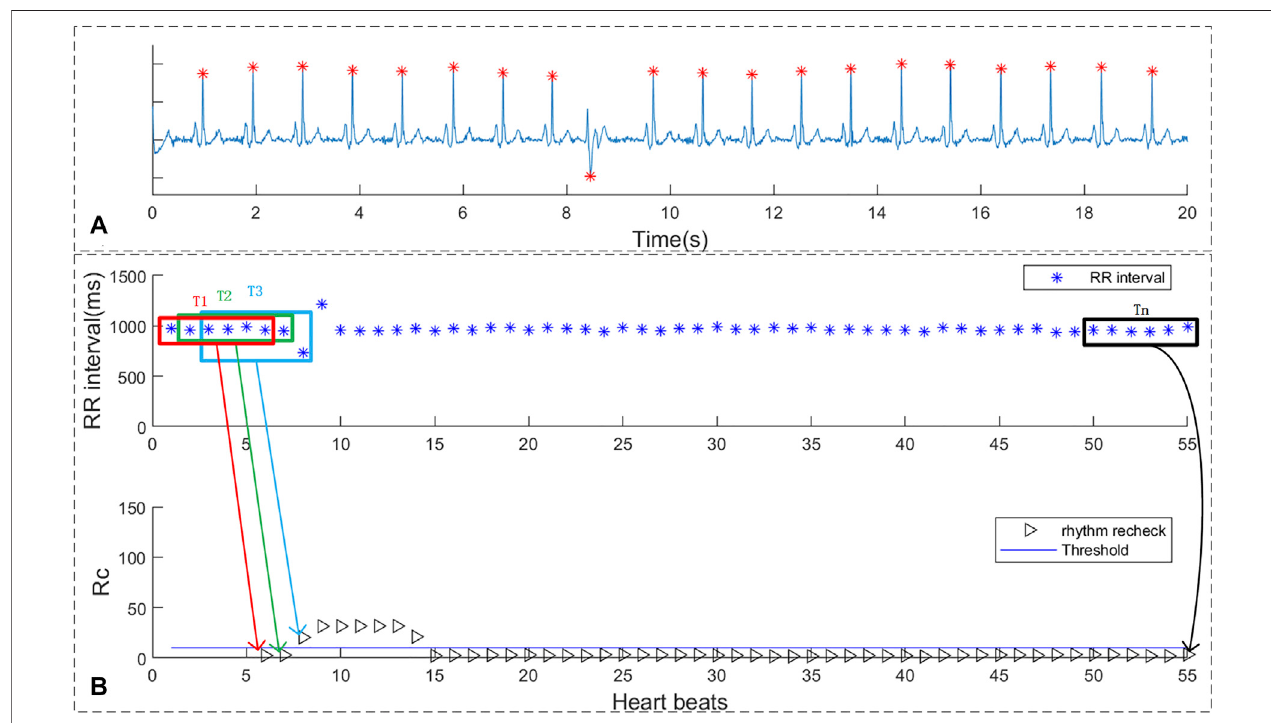
FIGURE6| TherhythmrecheckresultofECGwithsinglePVC. (A) ECGsegmentwithsinglePVCbeats; (B) RRintervalsandsuspicioussegmentscreeningresult.